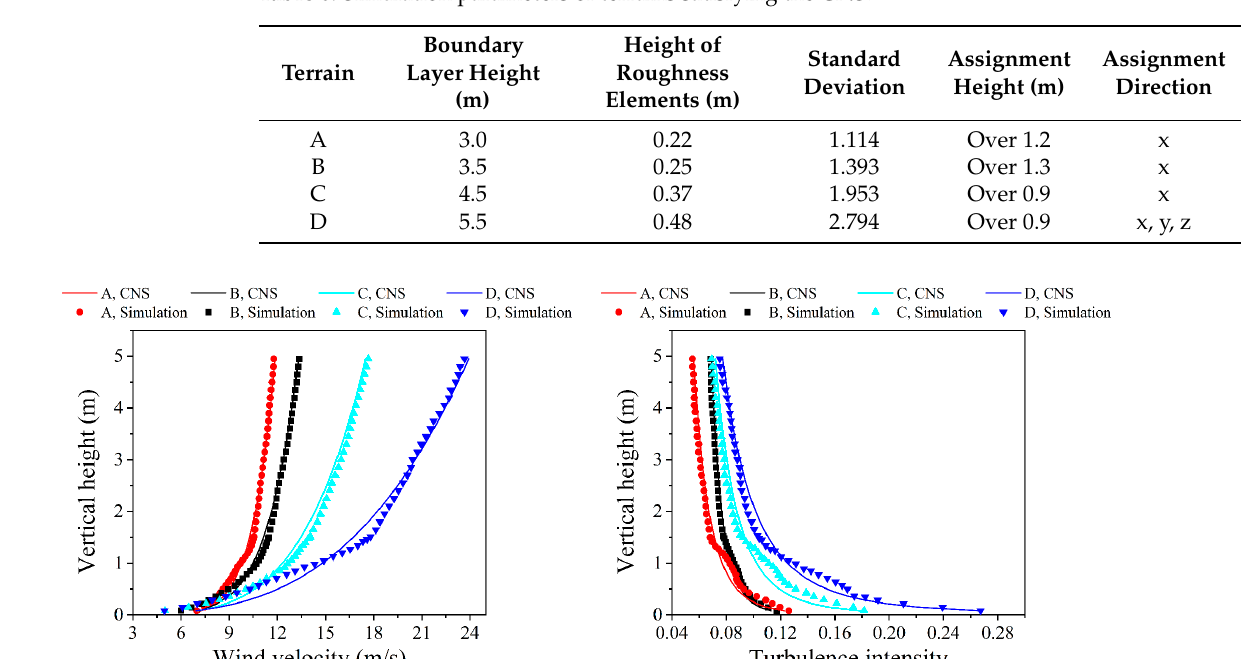
Table 6. Simulation parameters of terrains satisfying the CNS.